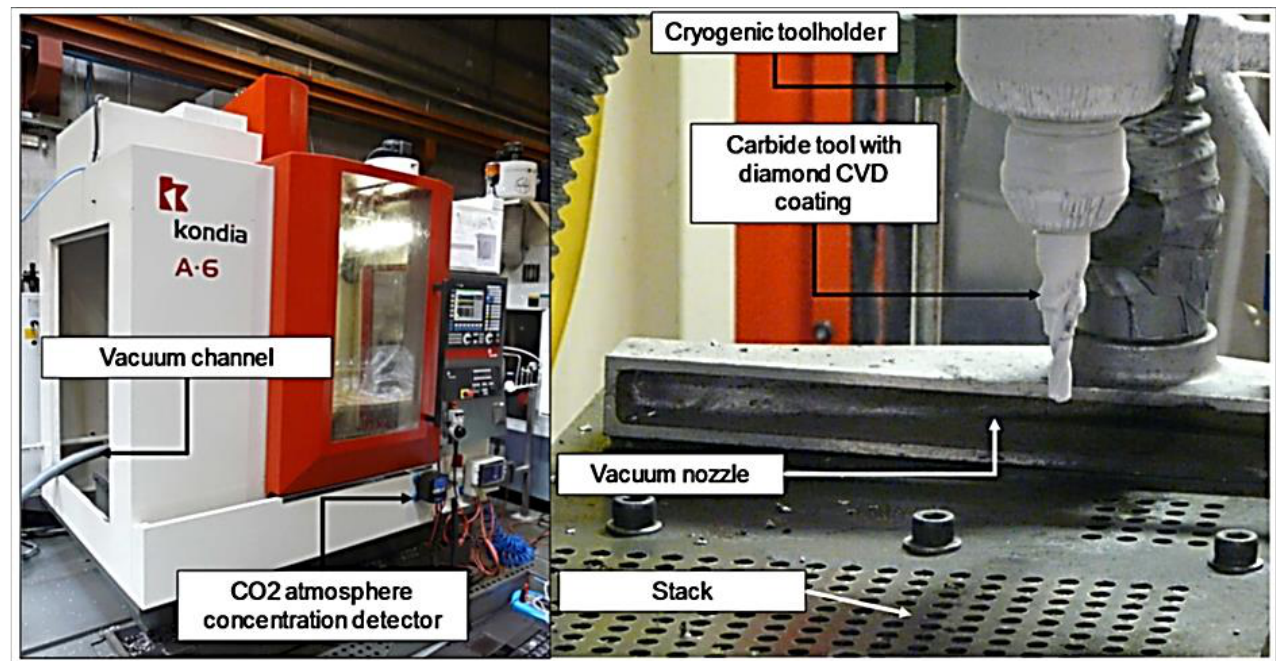
Figure 15. Experimental setup for drilling of carbon fiber reinforced plastic composites [132]. Reproduced with permission from Elsevier.